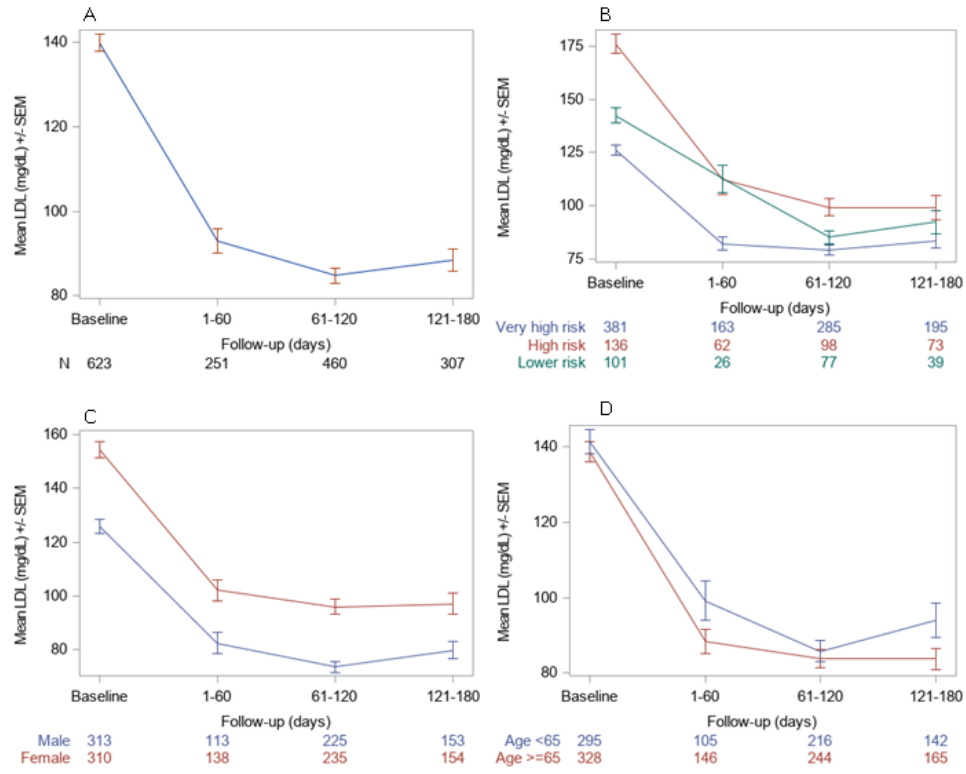
Figure 4. LDL-C absolute change from baseline during follow-up period by overall ( A ) and by CV risk ( B ), sex ( C ) and age ( D ) at baseline subgroups. Abbreviations: CV: Cardiovascular; LDL-C: Low-density lipoprotein cholesterol; SEM: Standard error of the mean.